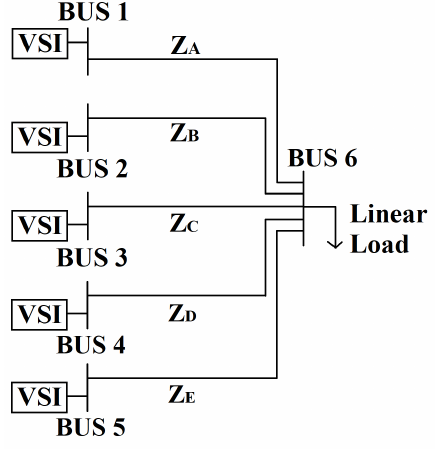
Figure 20. Microgrid of six buses.